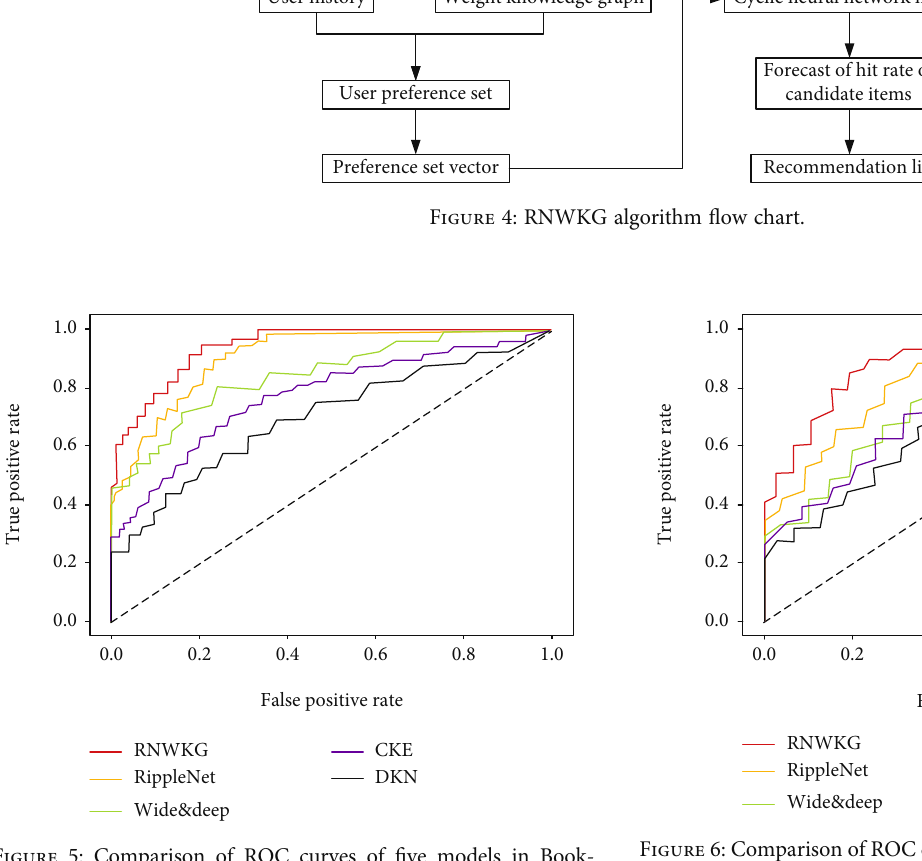
Figure 5: Comparison of ROC curves of fi ve models in Book- Crossing.